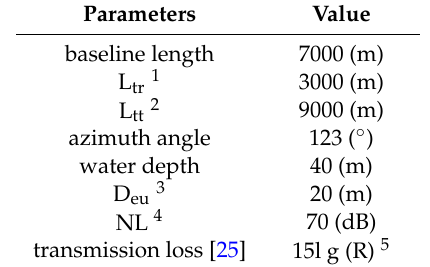
Table 1. Modeling and simulation parameters.